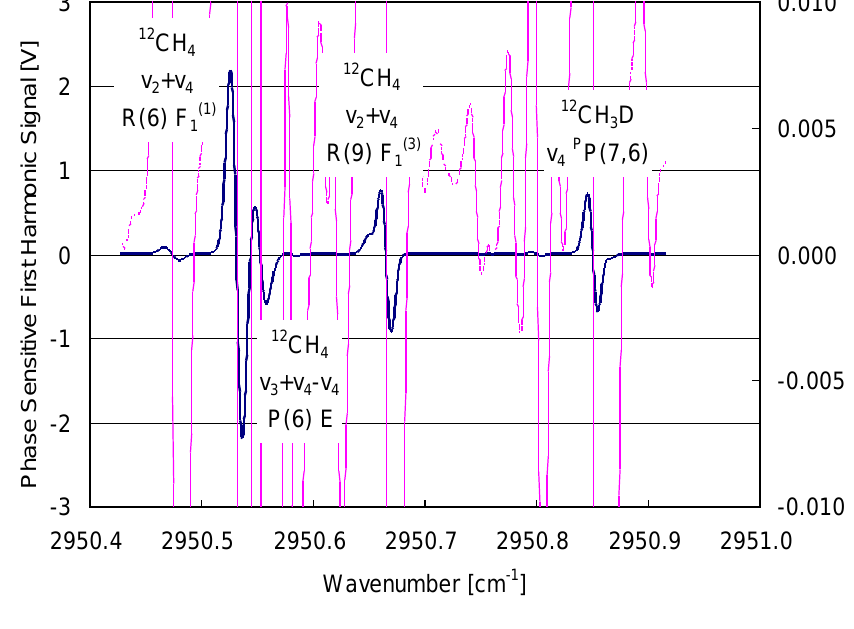
D and 12 CH 3 4